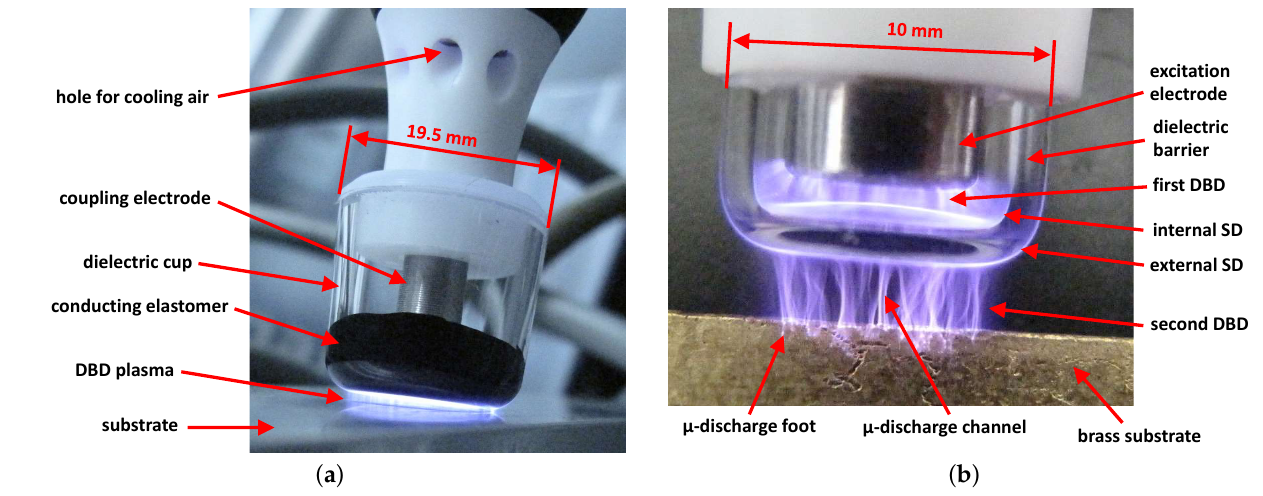
Figure 12. Two versions of the DBD producing, plasma bridge powered nozzles of the piezobrush ® PZ2 with explanations. ( a ) the proximity nozzle with single DBD; ( b ) the near-field nozzle with double